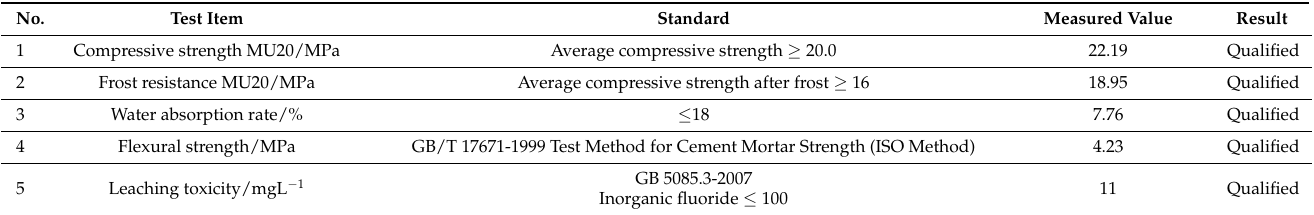
Table 6. Performance test results of E1